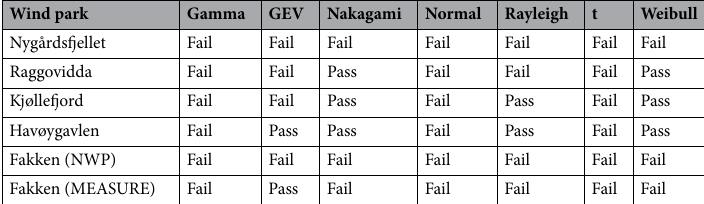
Table 4. The result of the K–S